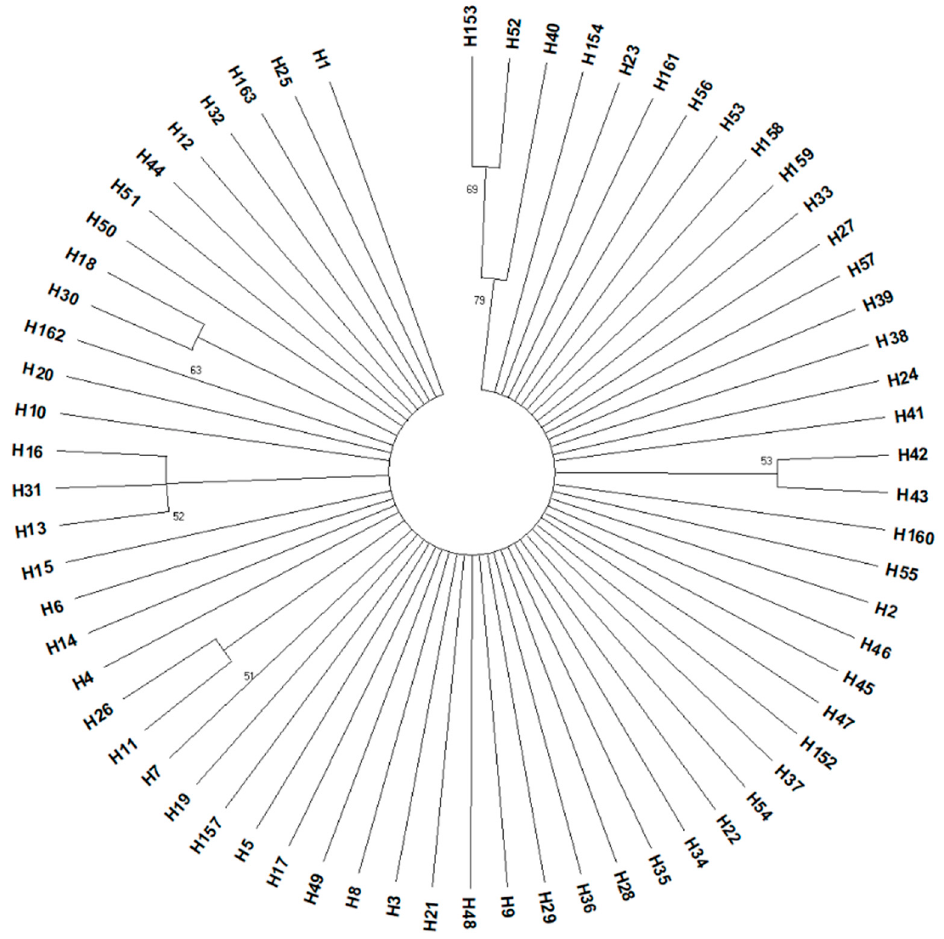
Figure 2. Phylogenetic tree constructed on haplotypes of COI for Halyomorpha halys using the Maximum Likelihood Tree Build Method based on the General Time Reversible model. Percentage bootstrap values from 1000 replicates superior to 50% are given at each node. Based on data from the present study and [6,14,26,27,35,45].